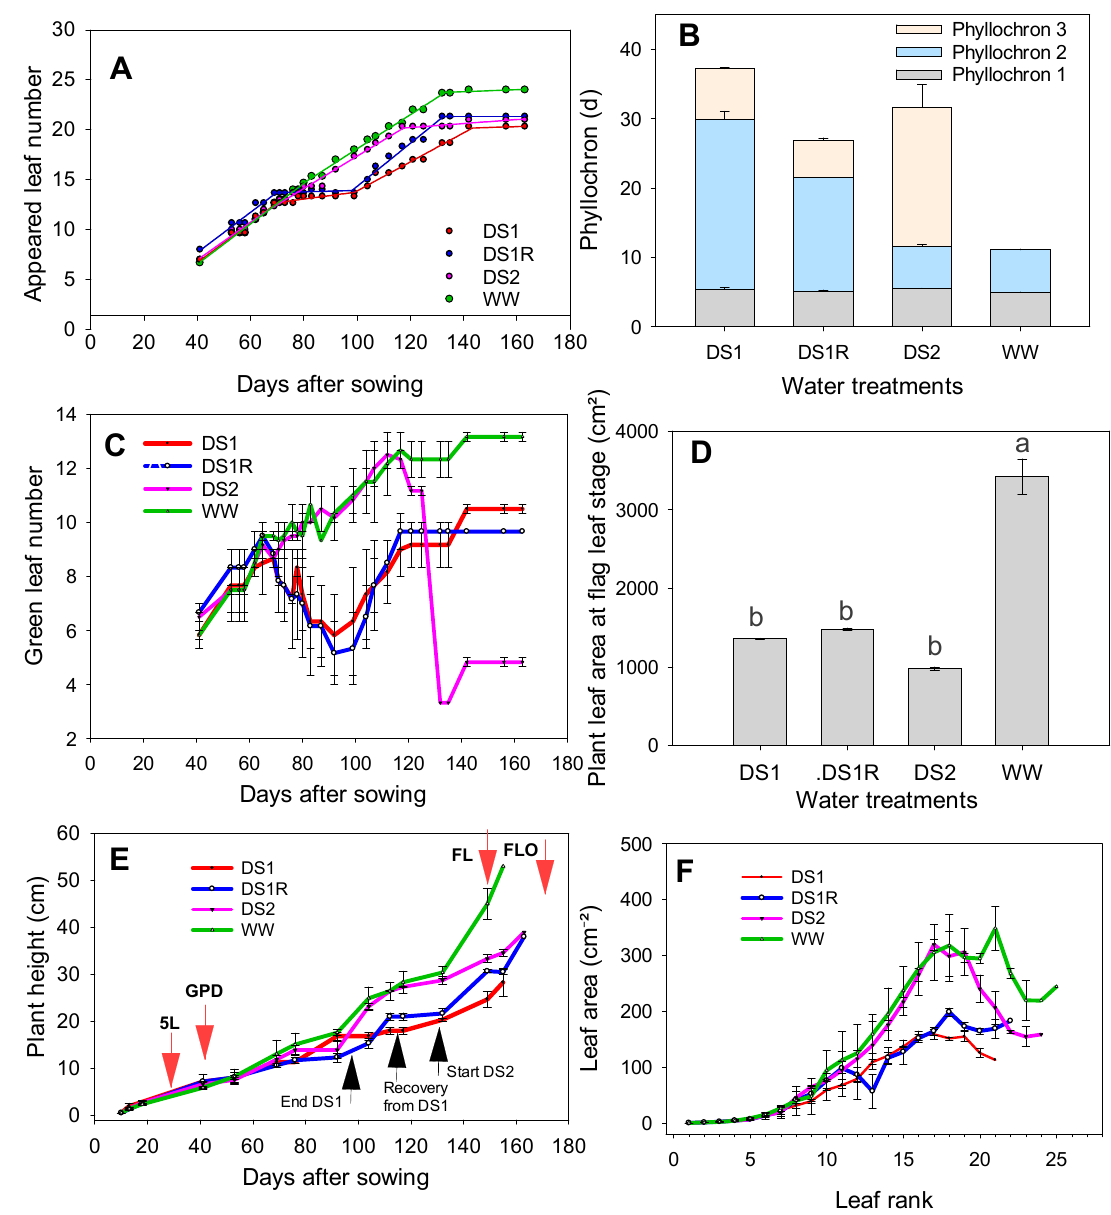
Figure 4. Leaf appearance rate ( A ), phyllochron ( B ), green leaves evolution ( C ), plant leaf area at flag leaf stage ( D ), plant height growth rate ( E ), and leaf area per leaf rank ( F ) compared among different water treatments. 5L: five leaf, GPD: growing point differentiation, FL: flag leaf stage, FLO: flowering. For plant leaf area at flag leaf stage, among water treatments, the mean values with different letters are statistically different (p< 0.05).